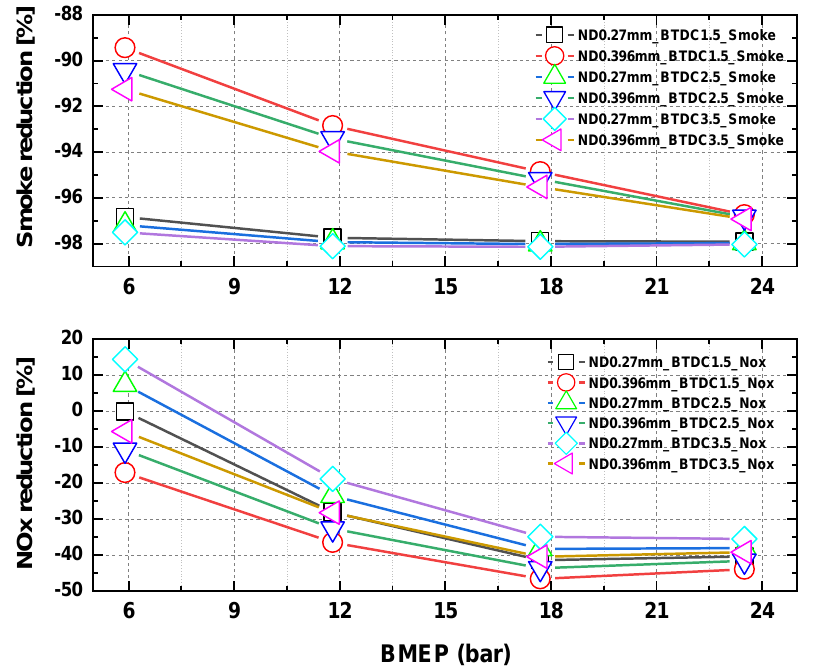
Figure 10. Characteristics of nitrogen oxide and smoke emissions versus start of injection timing and nozzle hole diameter for marine diesel fuel and DME fuel.